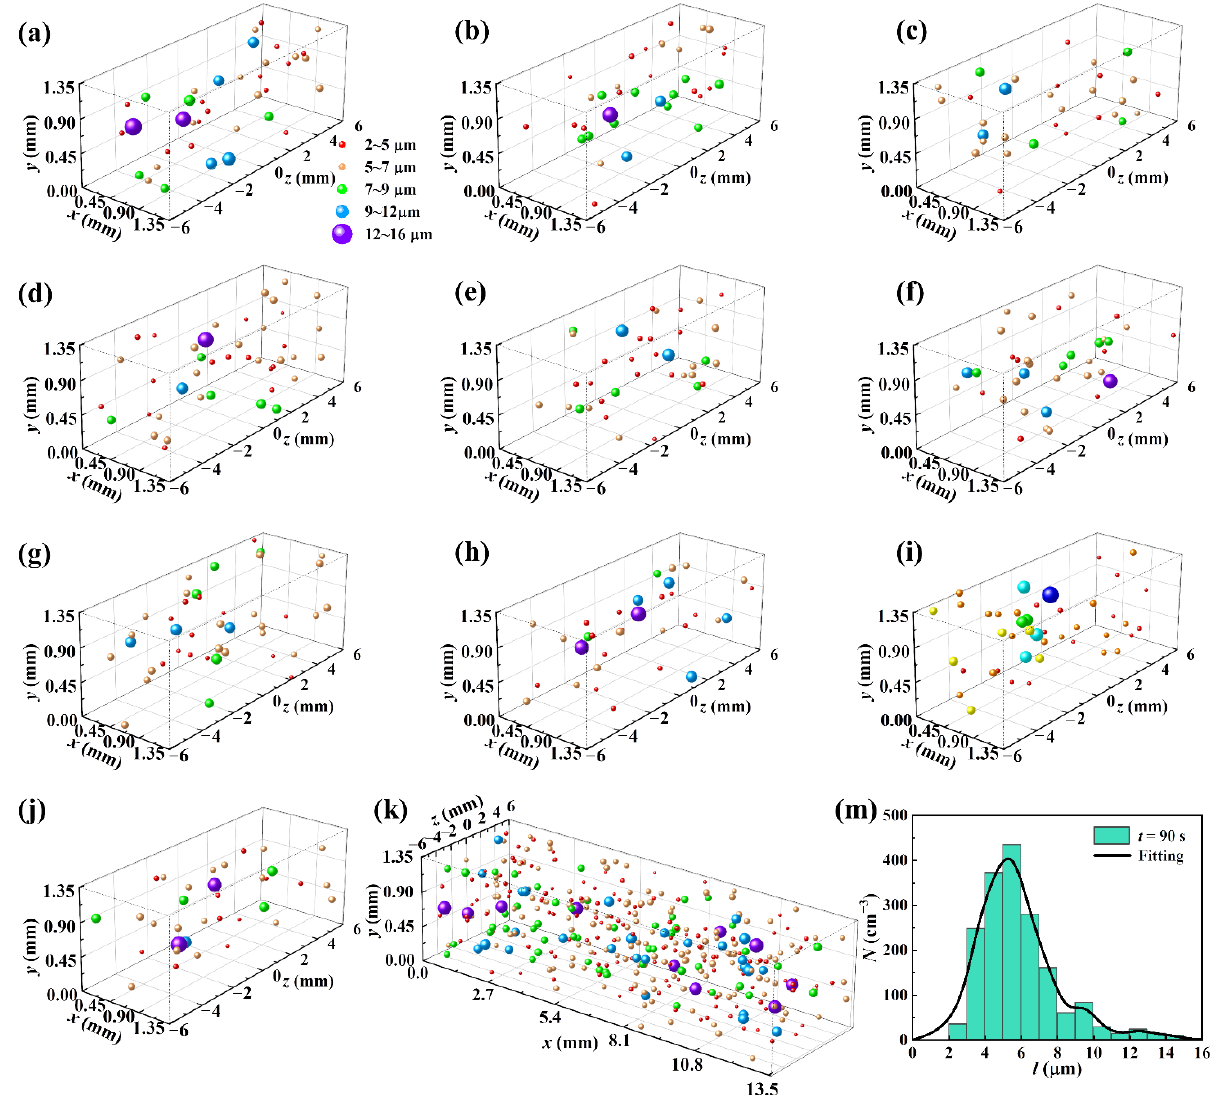
Figure 8. The three-dimensional distribution and DSD in the 90th second. ( a – j ) show the 10 three- dimensional distributions of cloud droplets in the detection area within 1 s. ( k ) The three-dimensional distribution fused by 10 distributions. ( m ) The DSD corresponding to the 90th second.